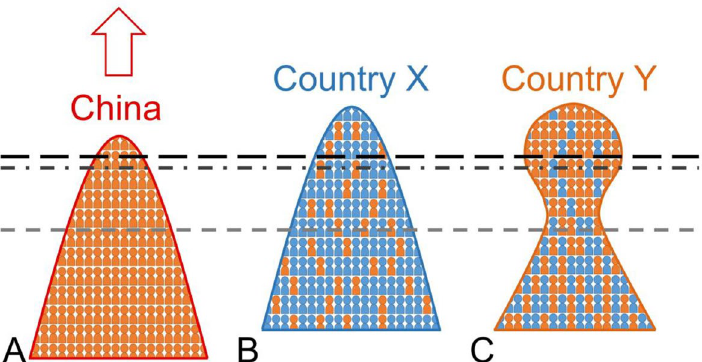
Figure 4. A resource distribution model of a country and the journal publication criteria for Nature and Science (black long-dashed line), Nature’s sister journals (dark grey dashed-dotted line), and other journals in Nature Index (grey dashed line). ( A ) The rise of China is denoted by the arrow. ( B ) Resource distribution of country X (e.g. USA and Germany) whose r C, ave remains low and does not reshape its original distribution. Our analysis indicates that the publication criteria of Nature and Science could be lower for the two countries. ( C ) Resource distribution of country Y (e.g. Singapore or Australia) whose r C, ave > 0.5 and has reshaped the distribution. Here the emigrated Chinese and domestic students are denoted by the orange and blue figures,